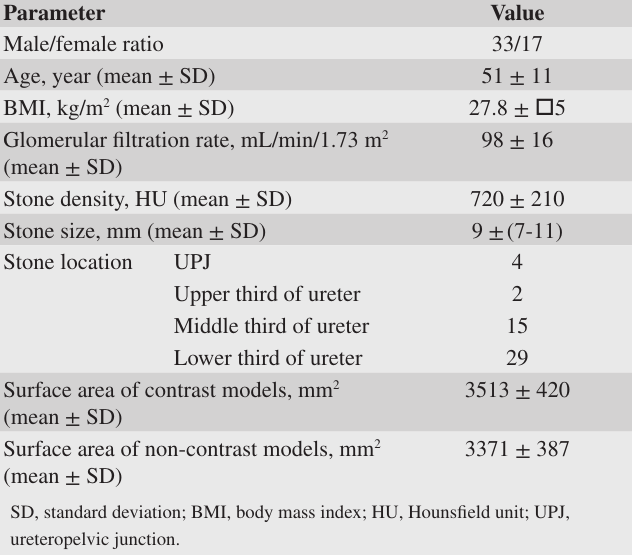
Table 1. Patients’ Demographics, Stone Properties, and Measurements of Models’ Surface Area